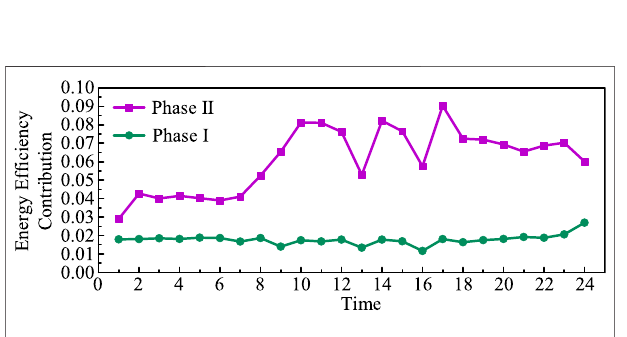
FIGURE 9 | The comparison of the heat subsystem.